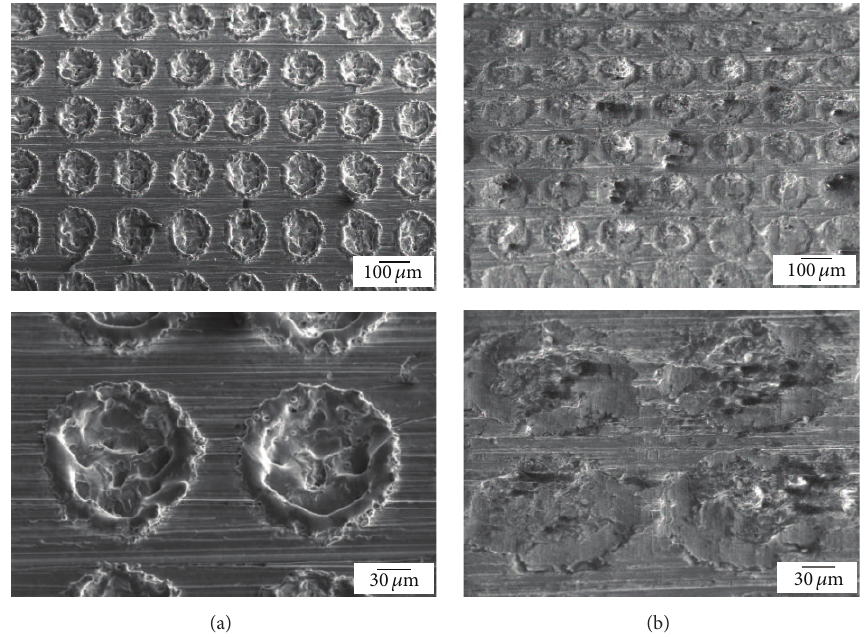
Figure 13: SEM images of die radius—texture #1: (a) before and (b) after hot stamping tests.